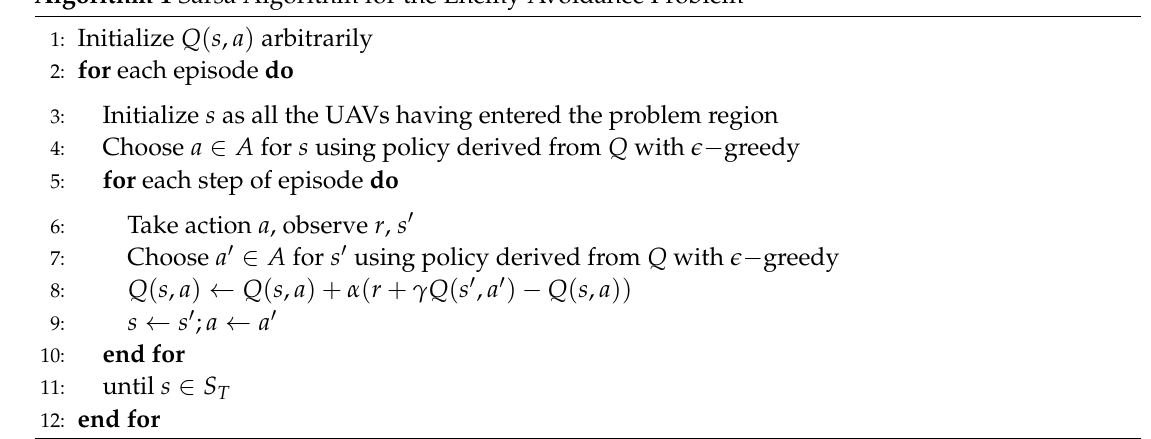
Algorithm 1 Sarsa Algorithm for the Enemy Avoidance